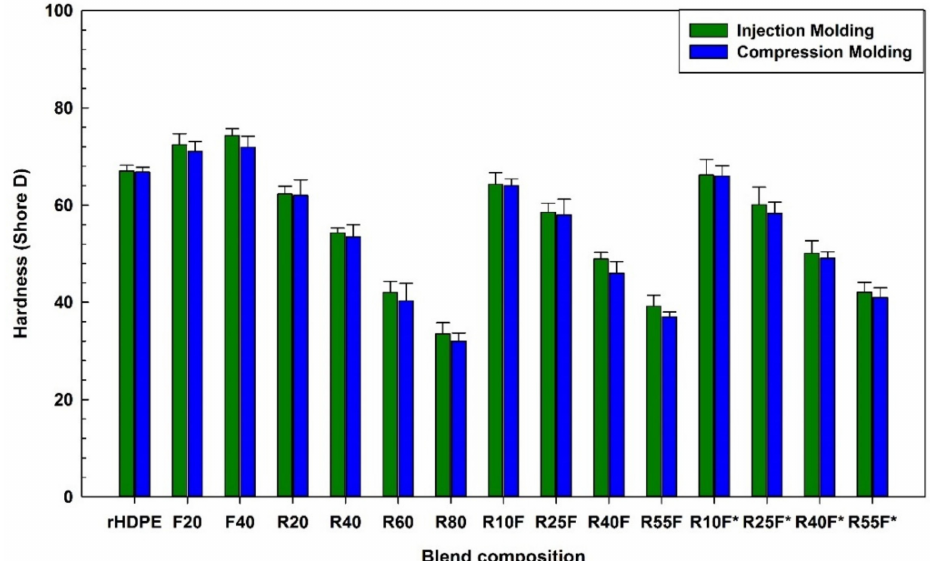
Figure 10. Hardness of the composites (see Table 1 for